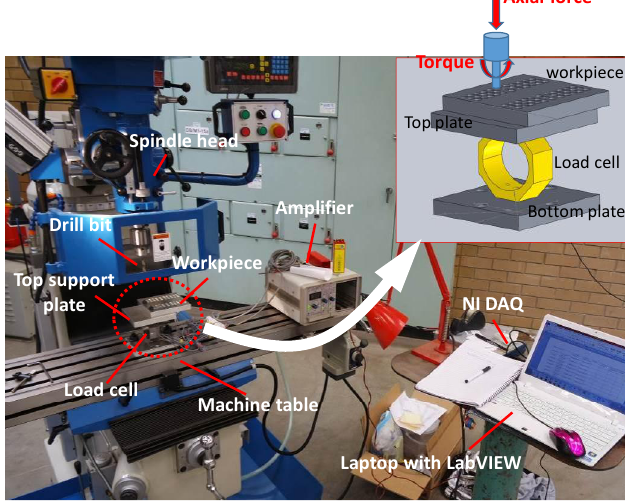
Figure 3. Experimental setup for drilling tests.